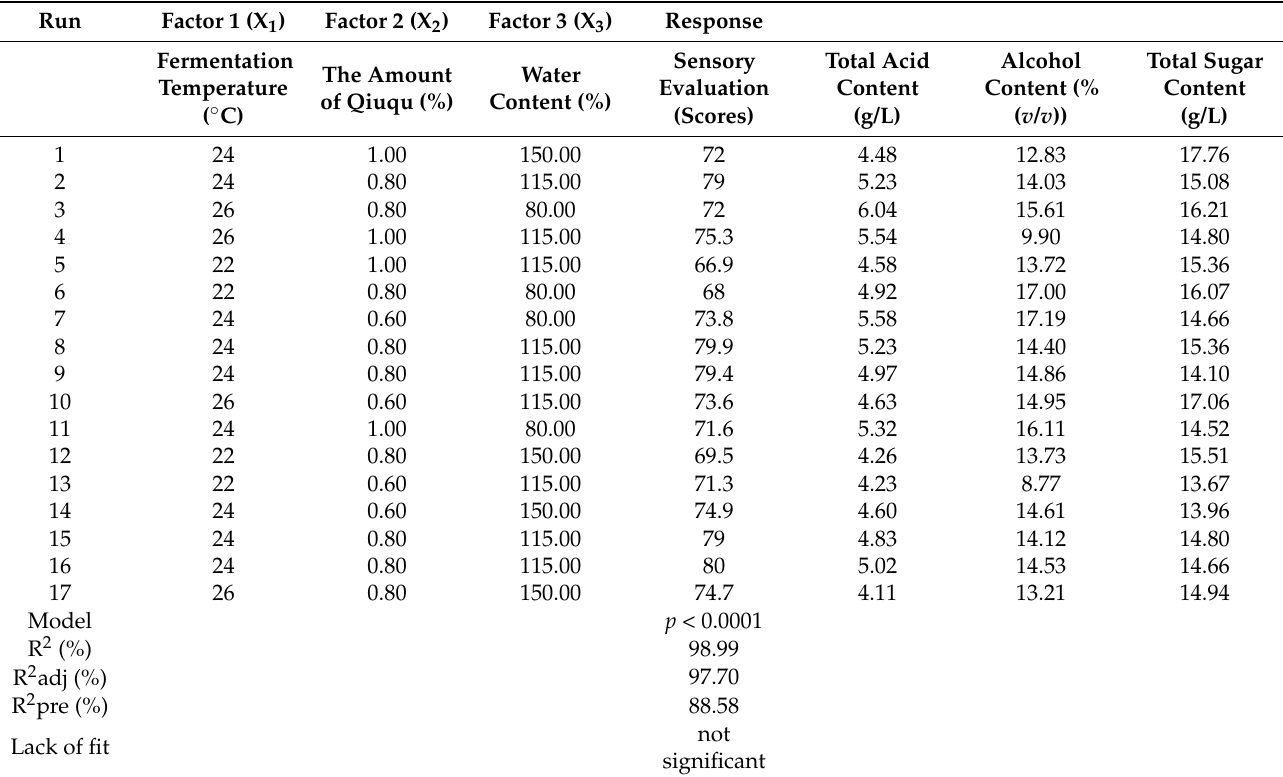
Table 1. Design and result of the response surface